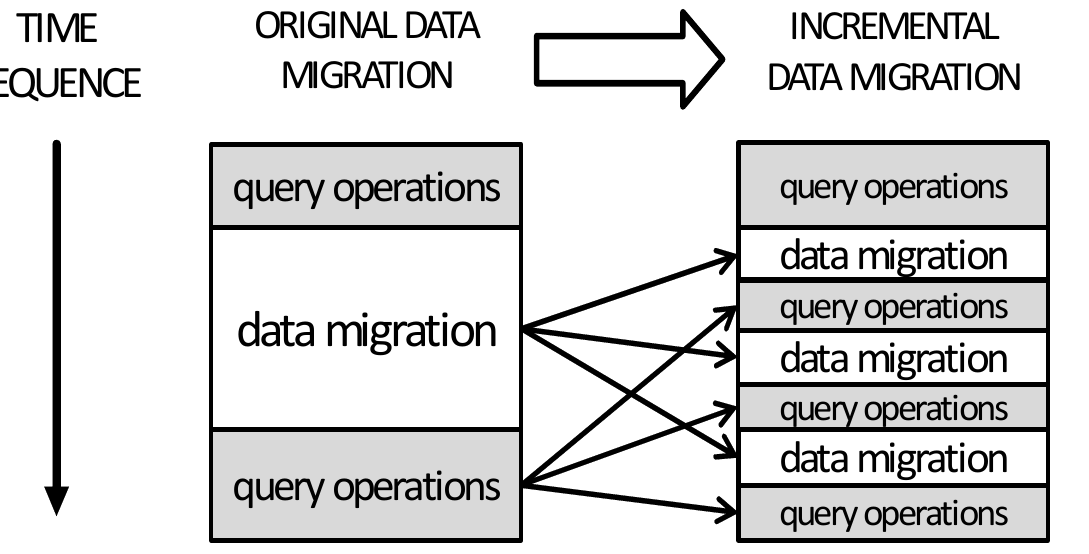
Fig. 3. the incremental scheme for the data migration